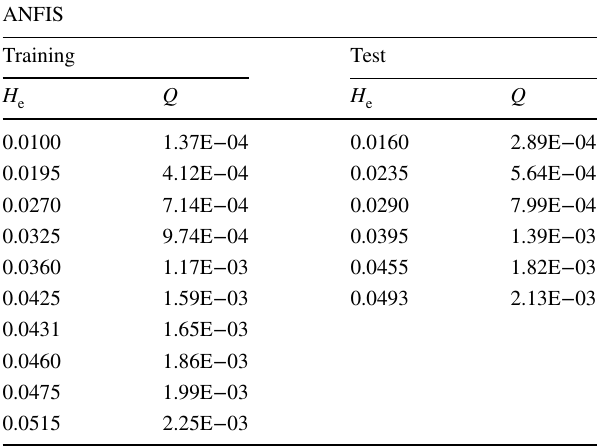
Table 3 Dataset used in ANFIS for training and test